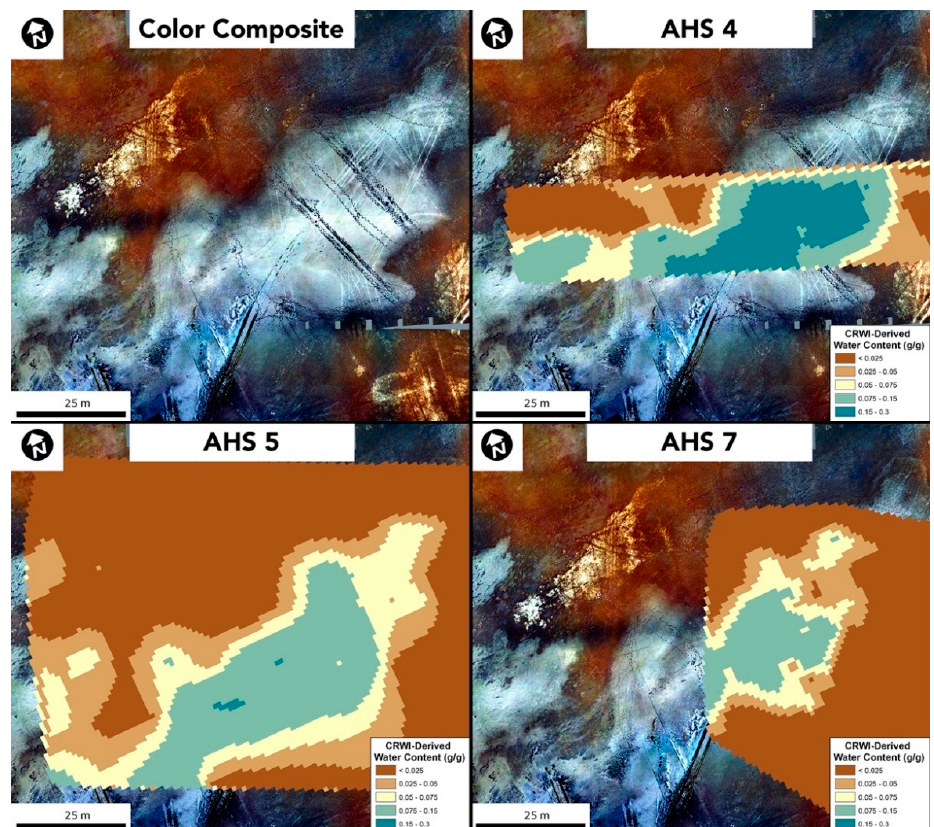
Figure 11. CRWI-derived soil moisture for each of the three completed overflights. Color composite panel shows just the color ortho-image of the Alvord hot spring plume. Panels AHS 4, 5, and 7 show gridded data for three drone sorties.